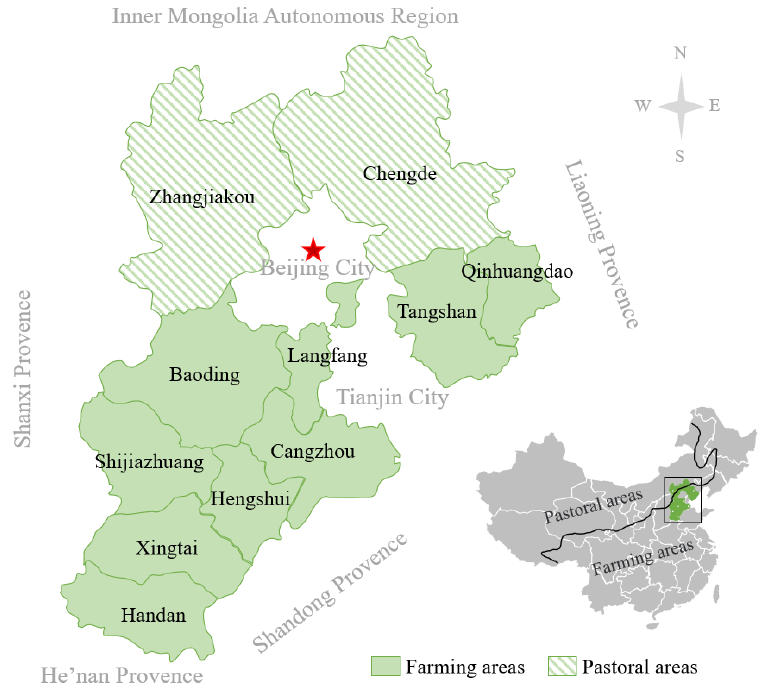
Figure 1. The Survey Farming Areas and Pastoral Areas.